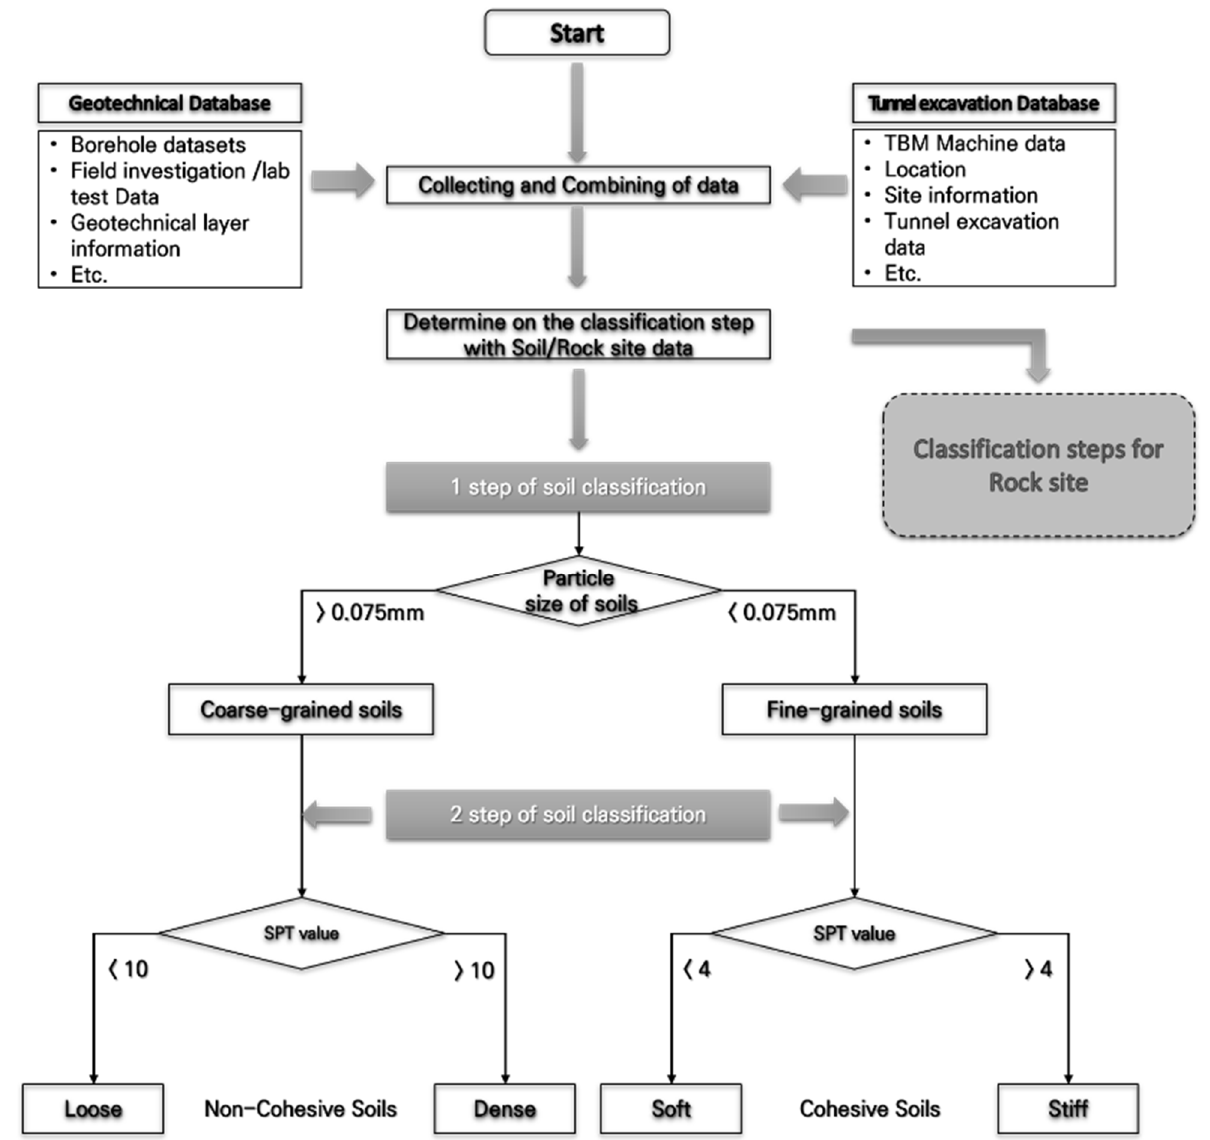
Figure 5. Soil classification procedure for the classification model.